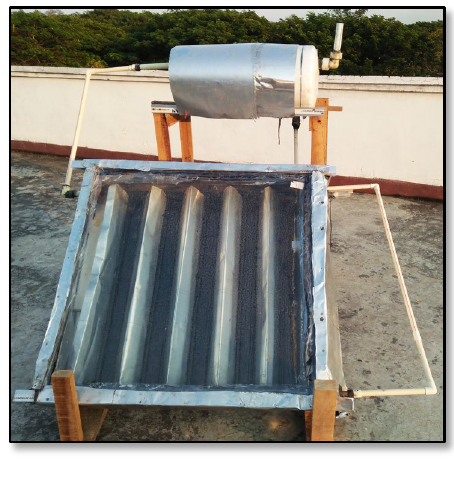
Figure 8. Setup of V-Trough SWH